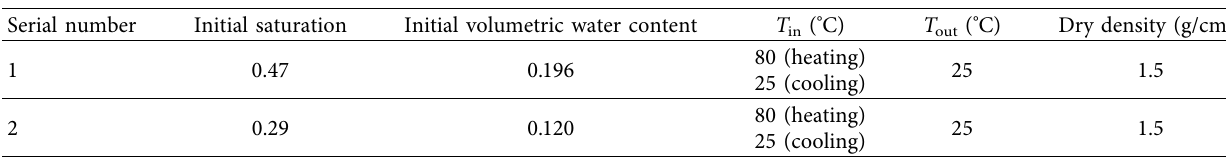
Table 2: Test schemes.